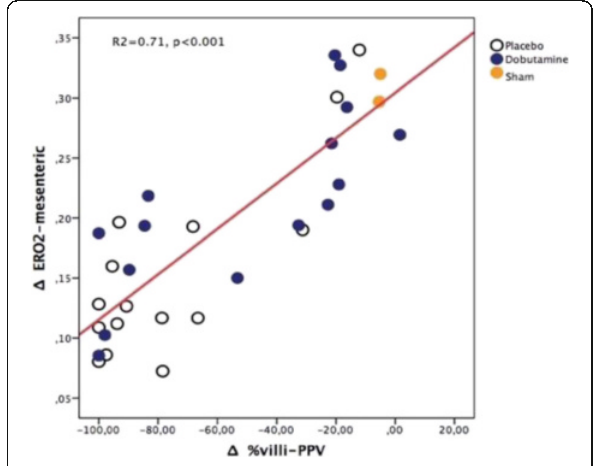
Table 84 (abstract A264). Peripheral perfusion